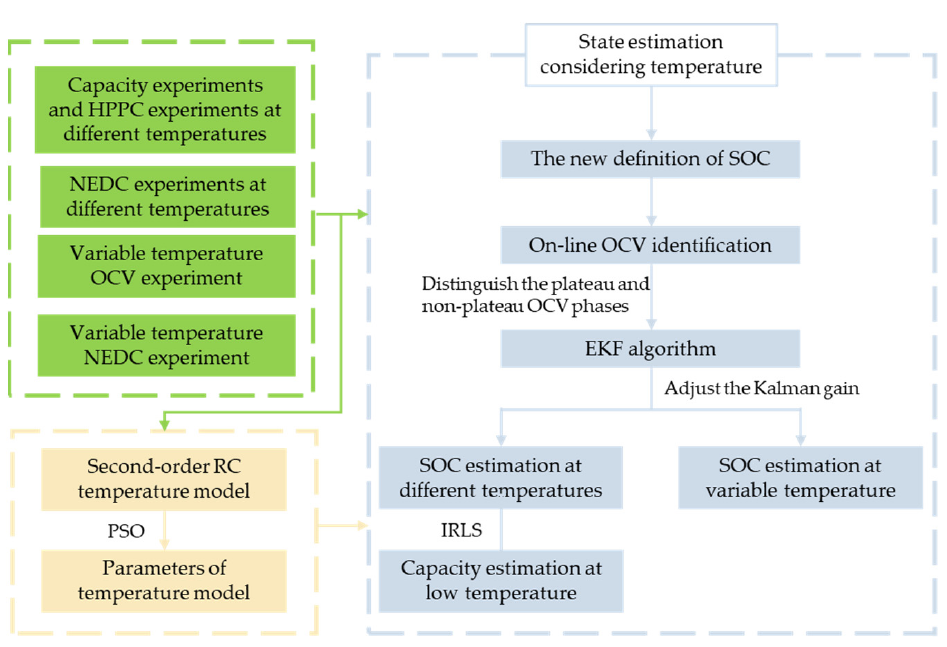
Figure 1. Framework diagram.